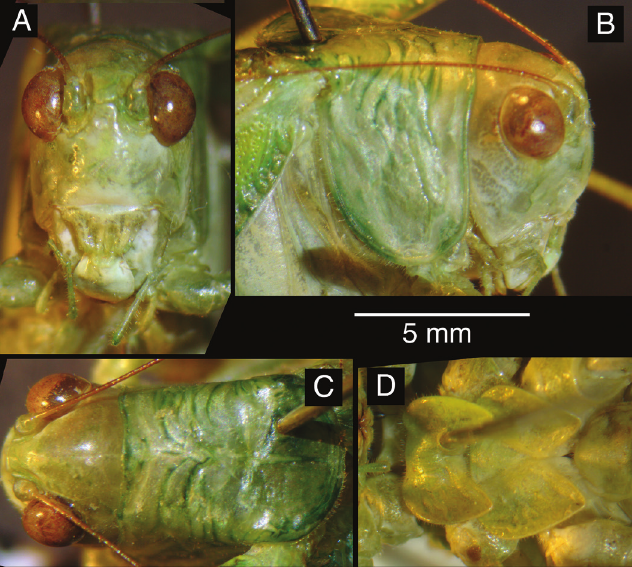
Fig. 2. Head and pronotum. A. Face (head frontal); B. Pronotum lateral; C. Fastigium verticis and pronotum dorsal; D. Meso- and metasterna, head to the left.